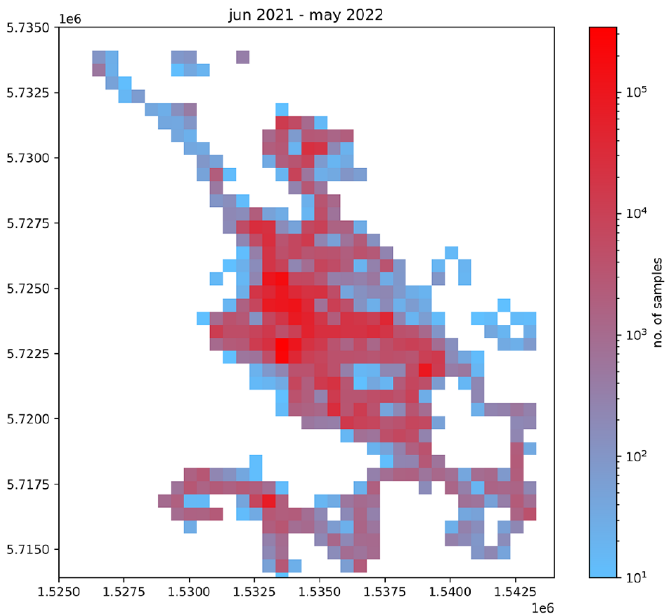
Figure 3. Acquisition density map in the designated area.